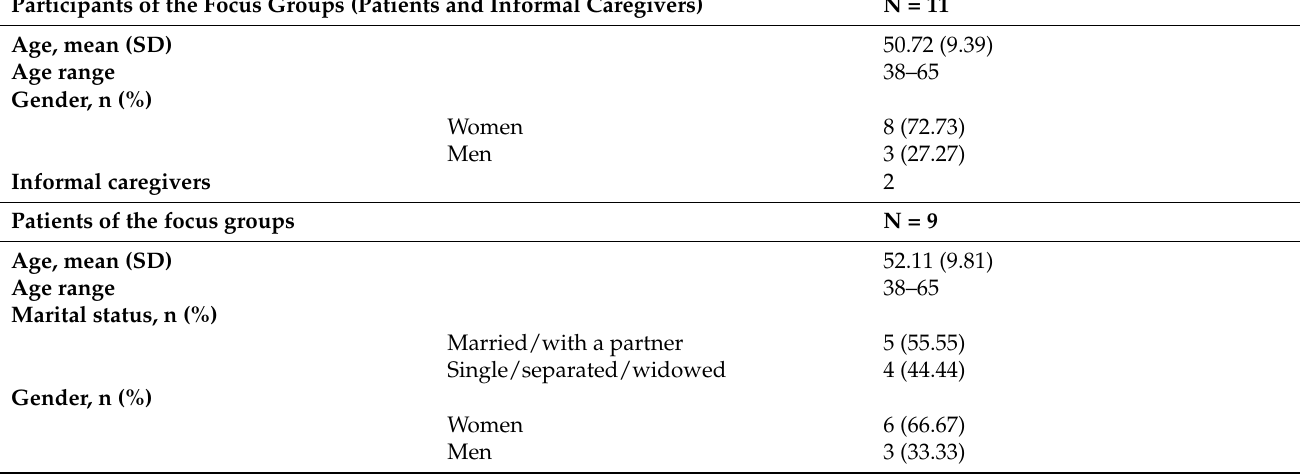
Table 1. General characteristics of